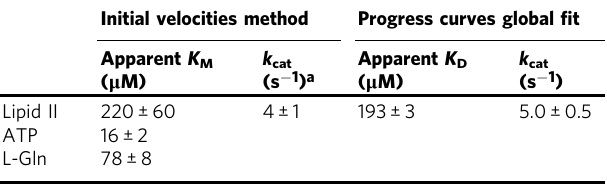
Table 1 MurT/GatD enzymatic parameters Initial velocities method Progress curves global fi